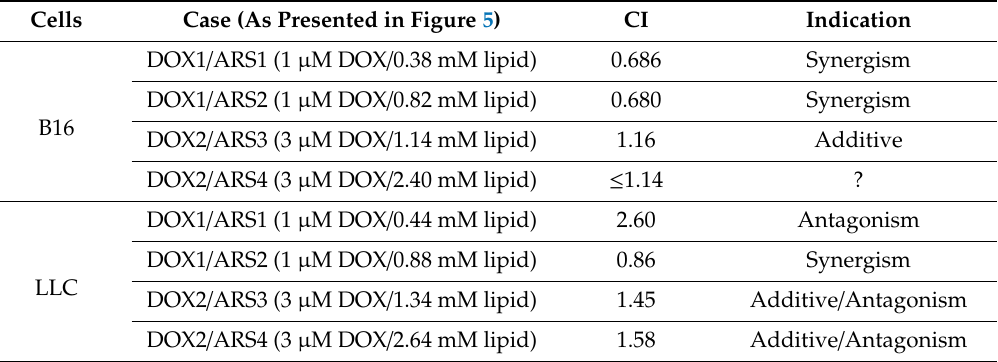
Table 4. Combination indices calculated from viability values obtained when DOX-ARSL were incubated with B16 and LLC cells for 24 h at 37 ◦ C.